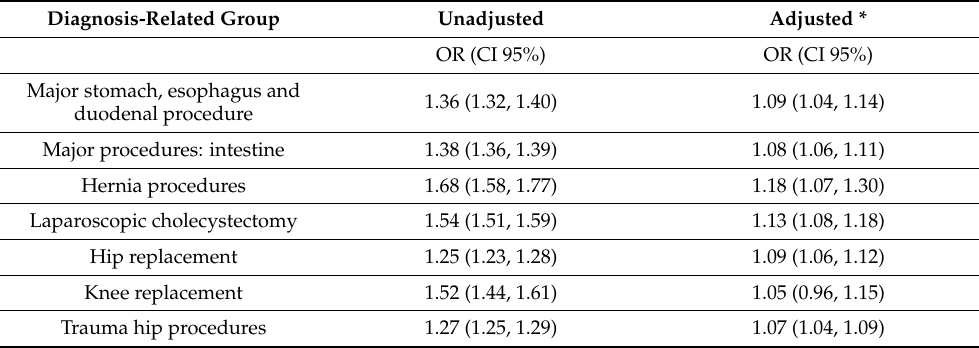
Table 4. OR of Unadjusted and Adjusted logistic regression models of HFRS as a risk factor for the incidence of postoperative sepsis for different DRGS.